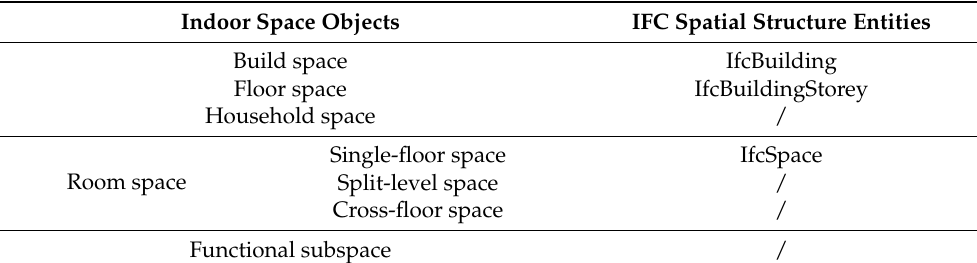
Table 2. Mapping relationship between indoor space objects and entities defined in